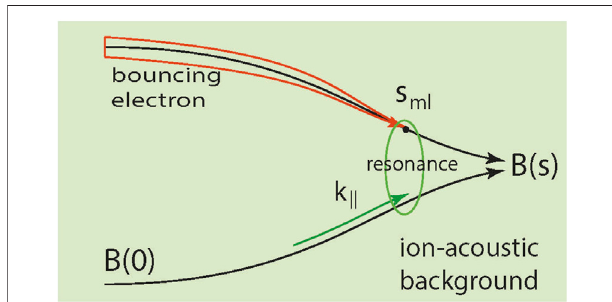
FIGURE1| Theunderlyingmodel:schematicofmirrorcon fi guration,the l th mirror point s ml , and resonance with an ion-acoustic thermal background wave with the parallel wave number k (cid:4) . The green oval indicates the region of resonant correlation and coherence which around the particular mirror pointistheDebyelengthintheparalleldirectionandatleastoneiongyroradius in the perpendicular